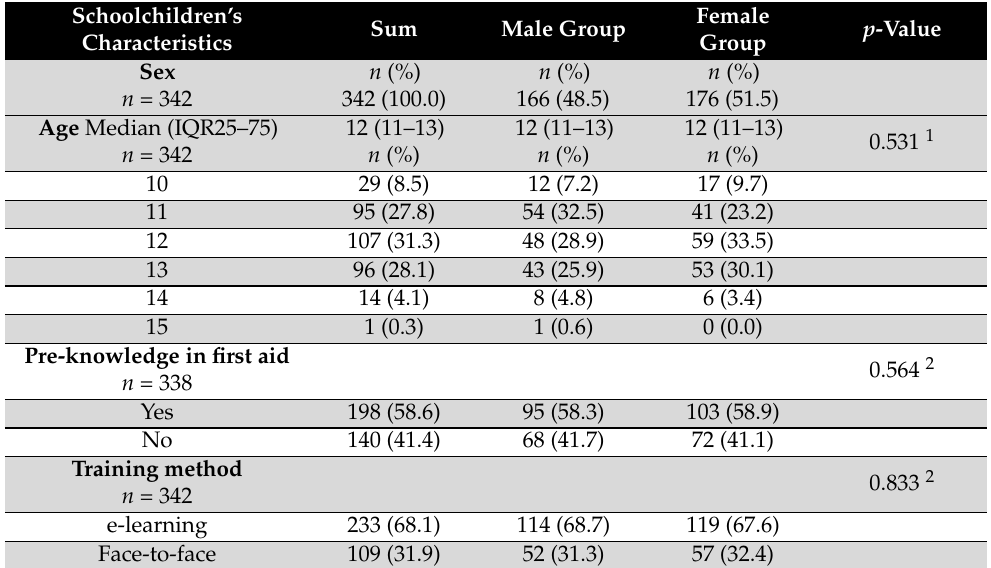
Table 1. Demographic characteristics of participating